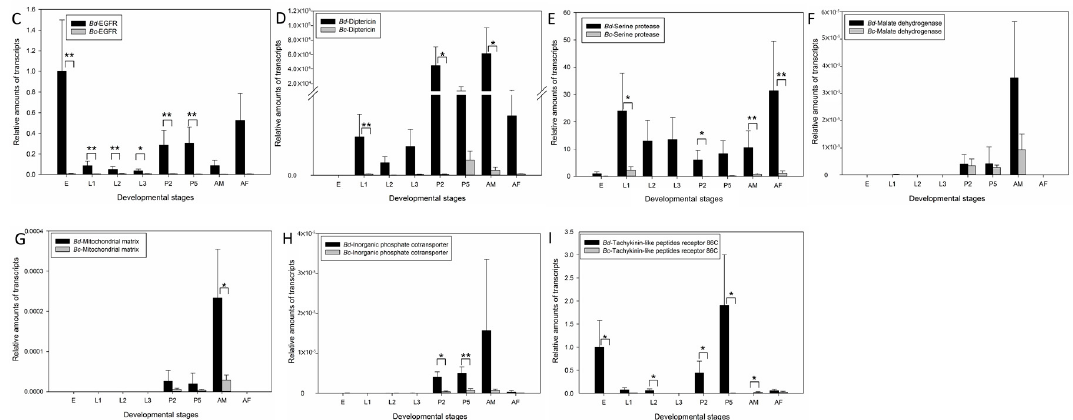
Figure 5. Differential expression and qRT-PCR verification of core genes in B. dorsalis and B. correcta . Heat maps of absolute expression measured as a normalized FPKM (fragments per kilobase of exon per million reads mapped) value from the perspective of larvae ( A ) and adults ( B ) in two species. The candidate genes tested ( C – I ) were selected to cover a range of biological processes contributing to flight. The bars represent the mean ± SD ( n = 3). ( Bd : B. dorsalis ; Bc : B. correcta ; F: female; M: male; E: eggs; L1: 1st instar larvae; L2: 2nd instar larvae; L3: 3rd instar larvae; P2: 2 days pupae after pupation; P5: 5 days pupae after pupation; AM: adult male; AF: adult female; * p < 0.05, ** p < 0.01, according to the Student’s t test).